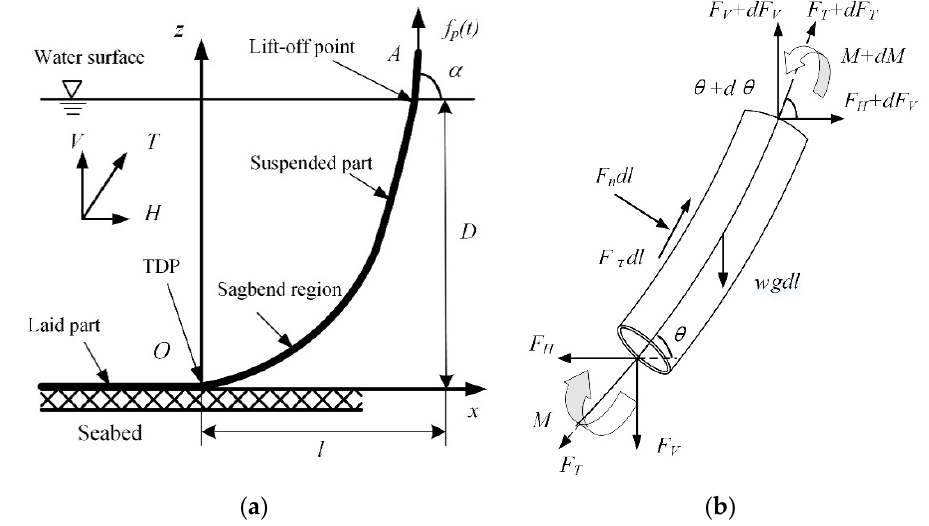
Figure 3. Underwater pipeline model: ( a ) Attitude of underwater pipeline; ( b ) Force of pipeline unit.